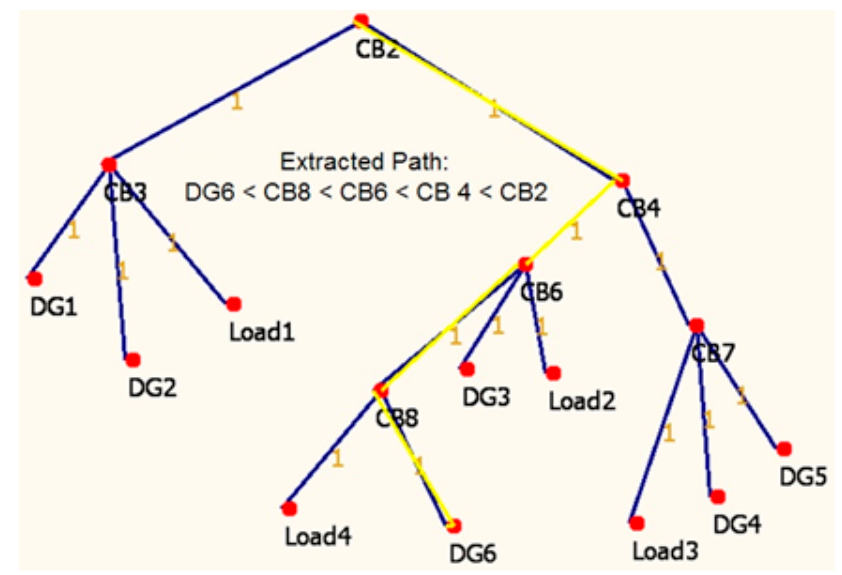
Figure 7. Dijkstra’s Algorithm after new deployments; path from CB2 to DG6.